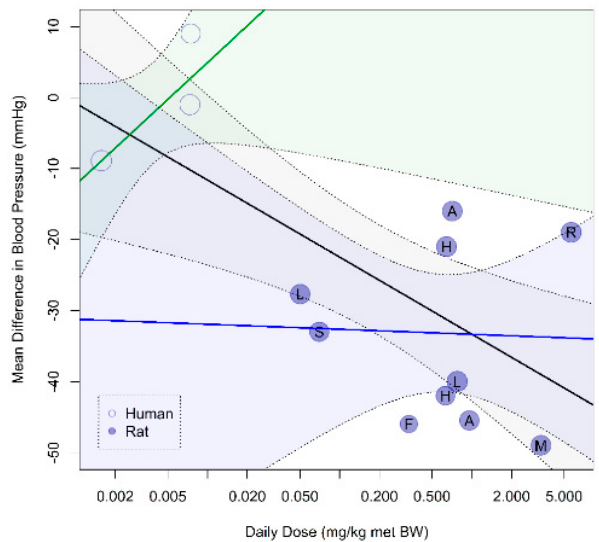
Figure A6. Dose-response curve of prenatal supplementation of arginine family on blood pressure (BP) in complicated pregnancies. Higher doses of arginine result in lower maternal blood pressure in complicated pregnancies ( p slope = 0.0031). However, this dose-response relation is influenced by an interspecies difference as the higher doses are tested in animal studies and lowest doses in human studies. Animal models for pregnancy complication included adriamycin nephropathy-induced preeclampsia (A), spontaneous hypertension and heart failure (F), hyperinsulinemic-induced PIH/FGR (H), L-NAME induced fetal growth restriction/preeclampsia (L), magnesium deficiency- induced fetal growth restriction (M), reduced uterine perfusion pressure-induced fetal growth restriction/preeclampsia (R), Sonic stress-induced preeclampsia (S). Daily dose is expressed as mg per kg metabolic body weight. Open dots indicate human studies and closed dots animal studies. Black line is drawn for all studies, yellow line for animal studies only and no line drawn for human studies since only 3 studies were available.